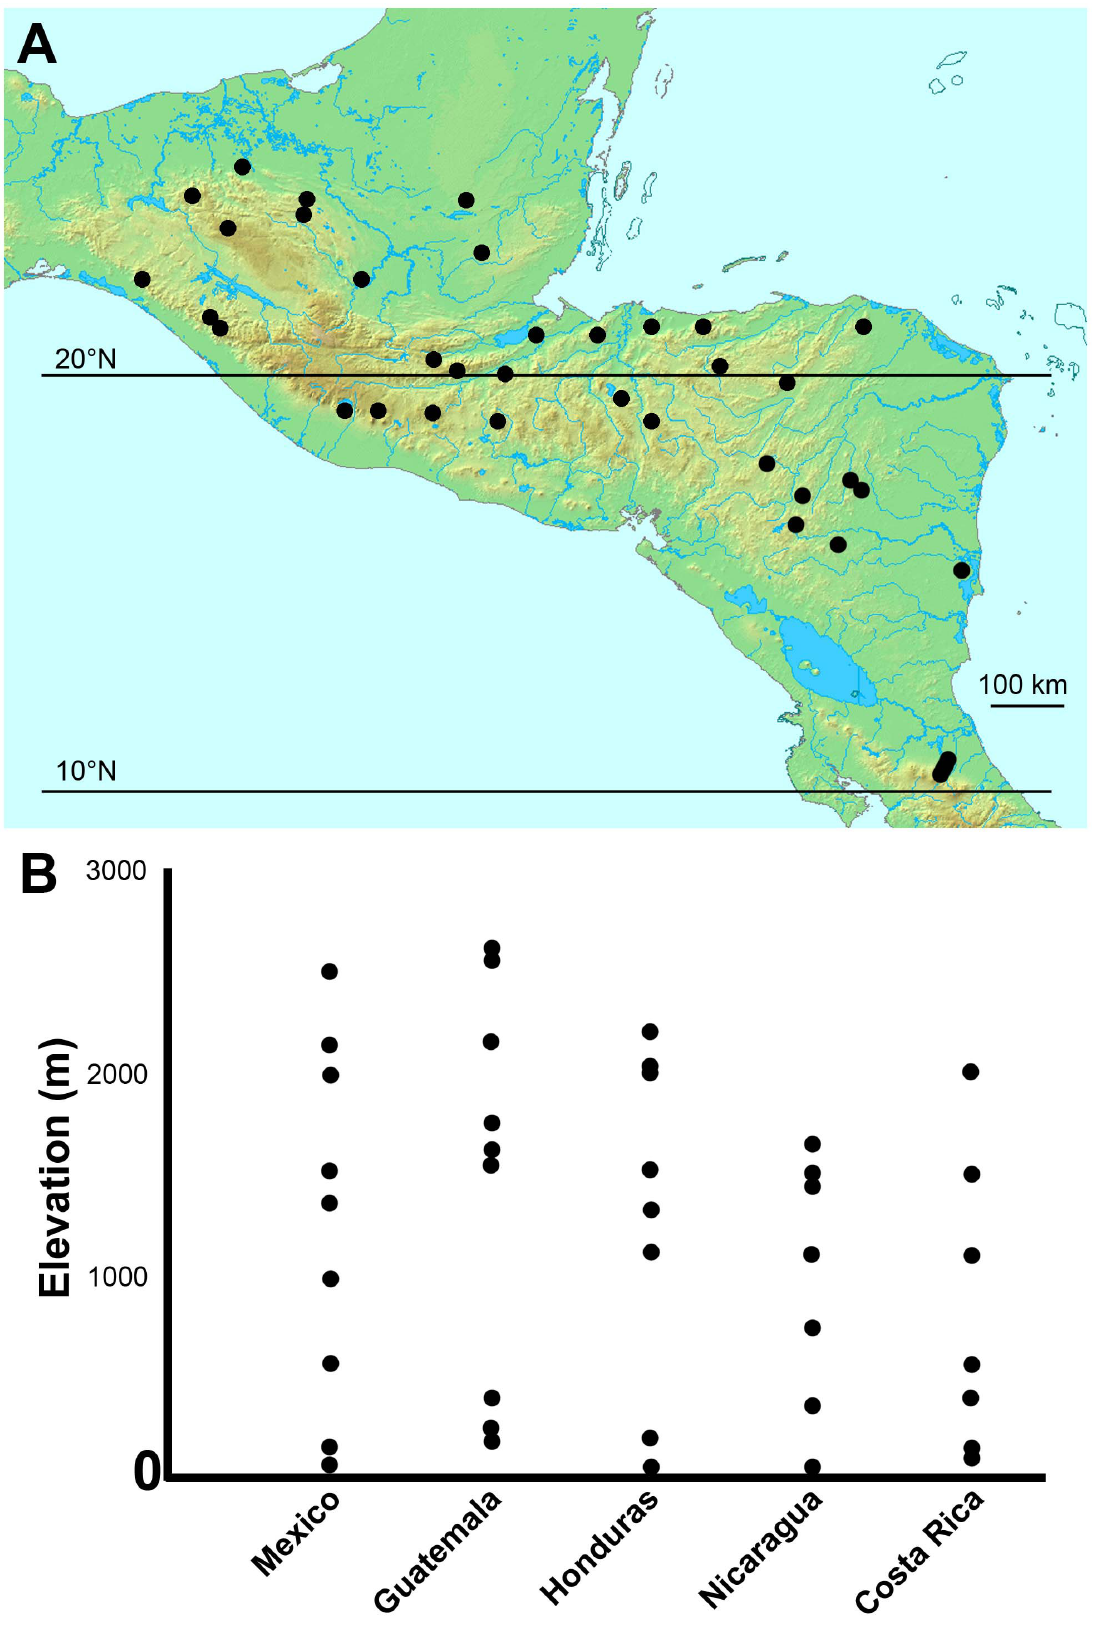
Figure 1. Geographic (A) and elevational (B) distribution of study sites. doi:10.1371/journal.pone.0104030.g001 PLOS ONE |